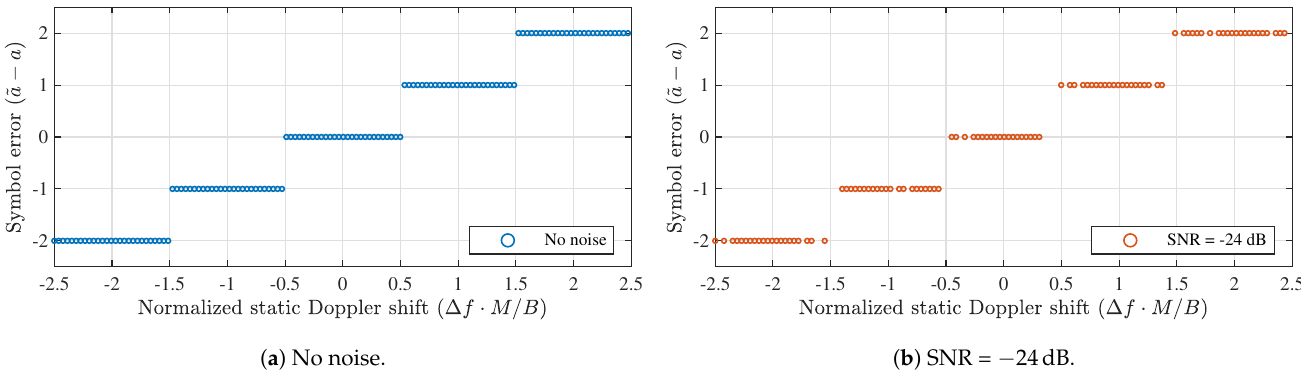
Figure 2. Symbol errors observed when detecting a synthesized LoRa symbol subject to different amounts of static Doppler shift. When no dot is present, the symbol error is outside [ − 2,2]. (SF = 12, B =